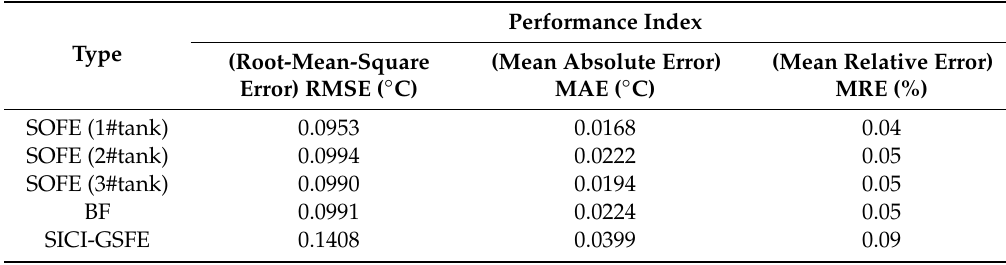
Figure 13. Absolute error of local measurement fusion, general batch fusion, and global fusion state estimation. Table 3. Comparison of performance indicators of local measurement fusion estimation, general batch fusion method in each cluster, and global state fusion